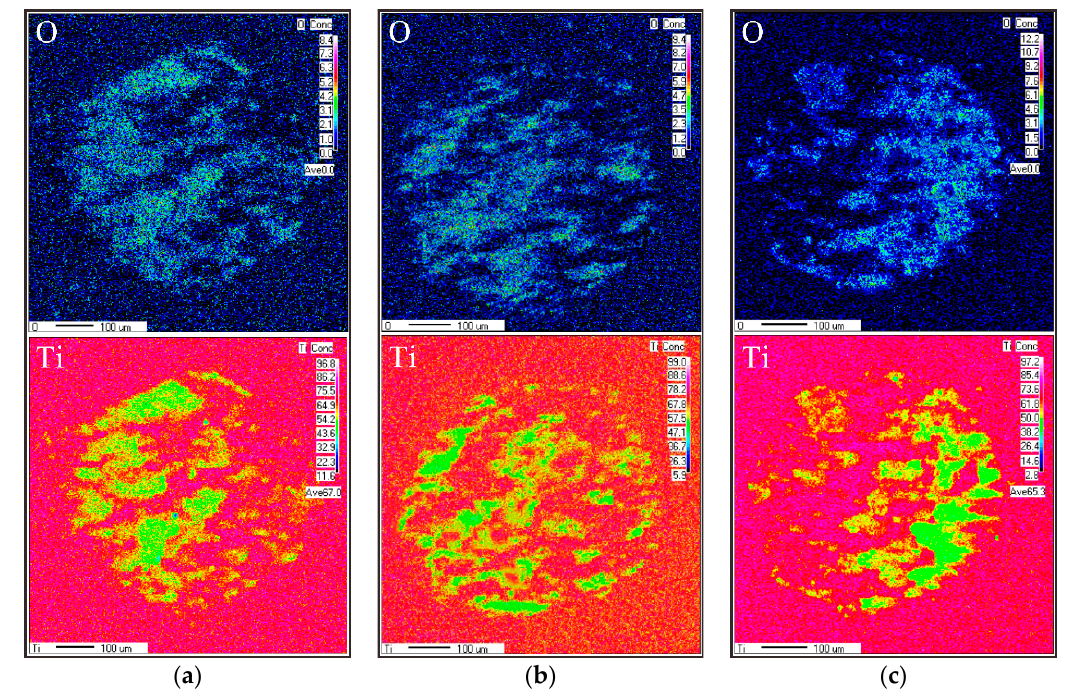
Figure 12. Electron probe microanalysis (EPMA) analysis on worn surfaces of three test samples, N = 3000. ( a ) Untreated; ( b ) 5 J treated; ( c ) 7 J treated.